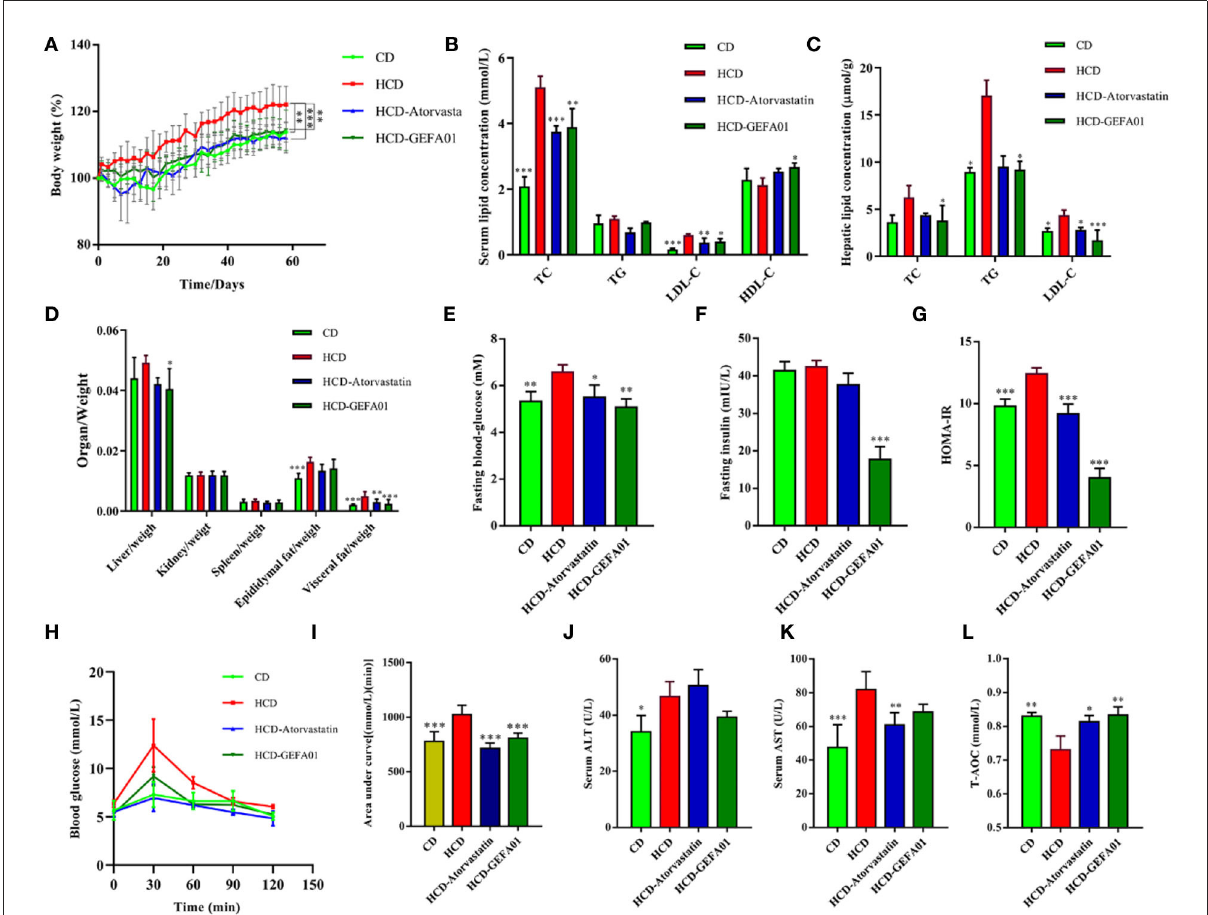
FIGURE3 E. faecium GEFA01 reduced the cholesterol level in hypercholesterolemic mice. (A) Body weight gain curves; (B) serum lipid levels including total cholesterol (TC), triglycerides (TG), low-density lipoprotein cholesterol (LDL-C), and high-density lipoprotein cholesterol (HDL-C); (C) hepatic lipid levels; (D) organ/weight; (E) blood glucose level after overnight fasting at 8 weeks; (F) fasting insulin level in plasma by ELISA; (G) homeostatic model assessment-insulin resistance (HOMA-IR) index, calculated by fasting blood glucose (mmol/L) × fasting insulin (mU/L)/22.5; (H) glucose tolerance test (GTT); (I) area under glucose tolerance curve; (J) serum alanine aminotransferase (ALT) and (K) aspartate aminotransferase (AST) levels; and (L) serum T-AOC, total antioxidant capacity. Data were expressed as mean ± SEM: n = 4 animals per group; * p < 0.05, ** p < 0.01, *** p < 0.001, all groups were compared to the HCD